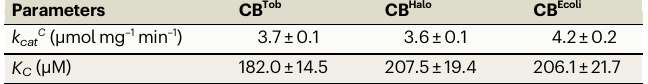
Data arepresented as mean±SD( n =3 independently biological